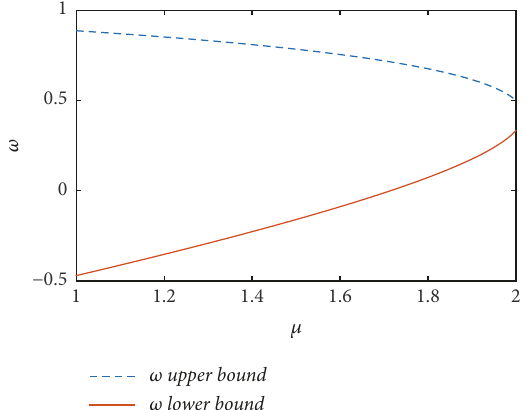
Figure 1: The relationship between 𝜇 and 𝜔 for mean square convergence of